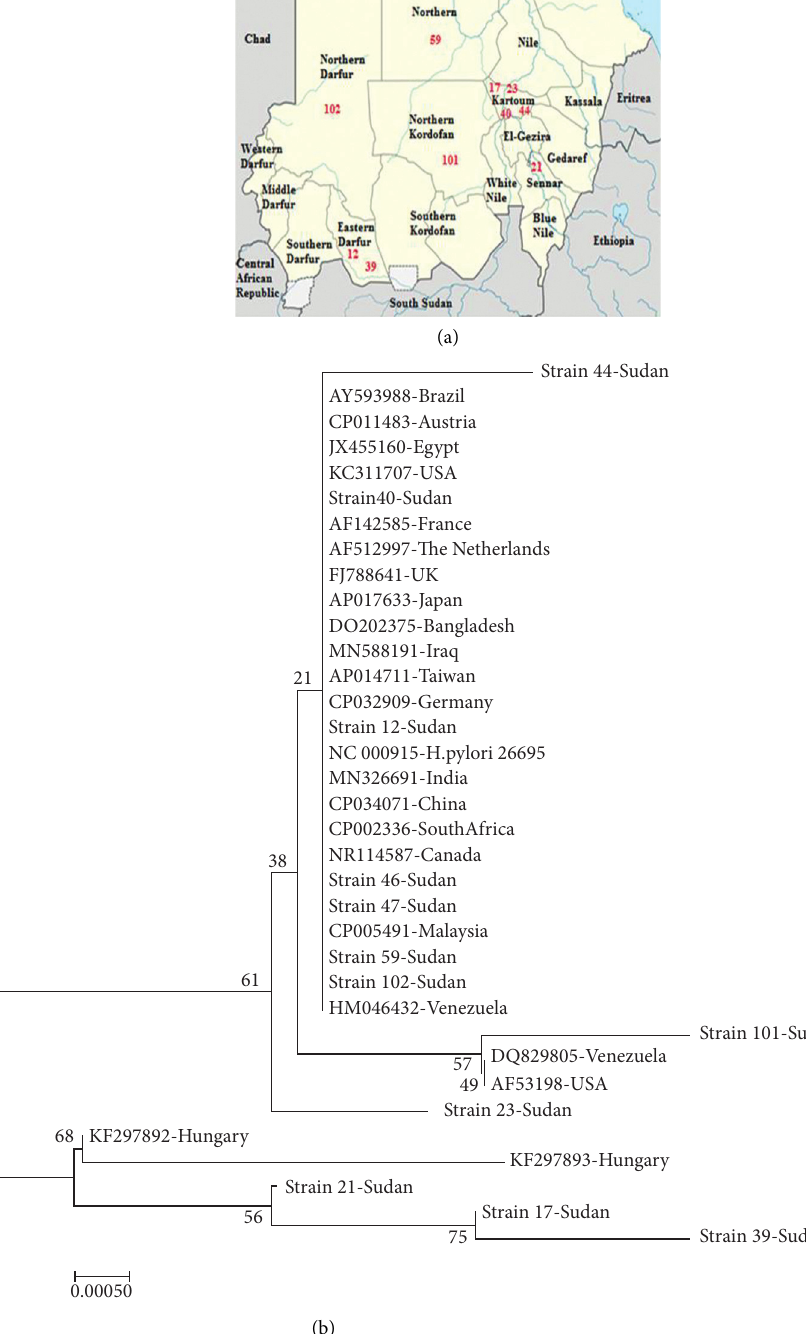
Figure 3: Distribution and evolutionary relationships of Sudanese H. pylori strains. (a) Map of the regional origin of strains in Sudan. (b) The Neighbor-Joining Phylogenetic tree. The percentage of replicate trees (1000 replicates) is shown next to the branches. The evolutionary distance was computed using the JC method and is in the units of the number of base substitution per site. Evolutionary analyses were conducted using